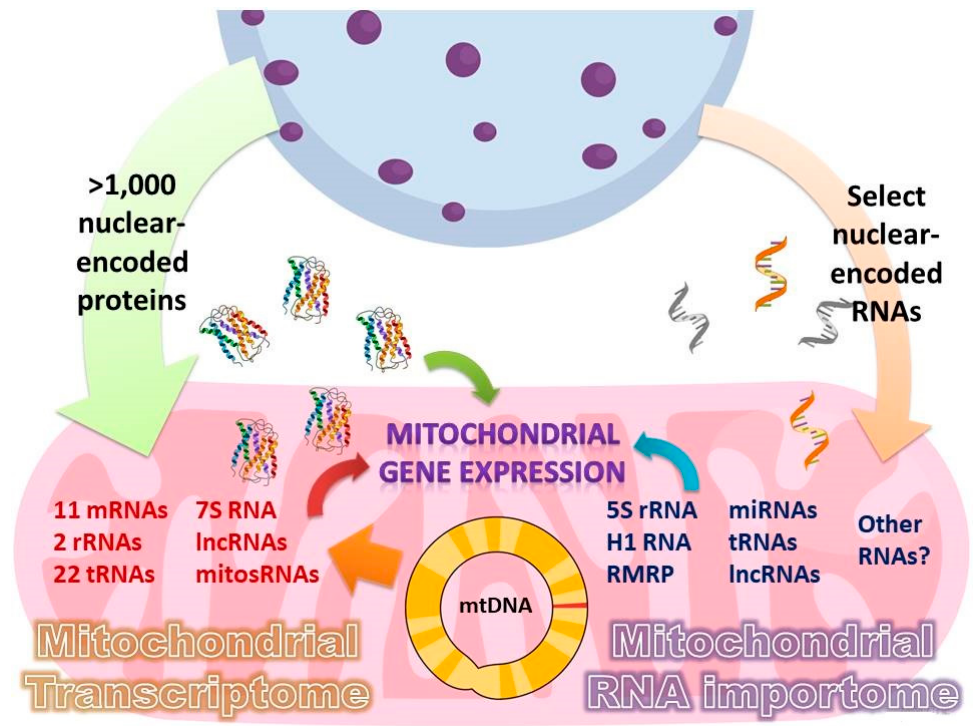
Figure 1. Human mitochondrial proteome and RNome are chimeric.